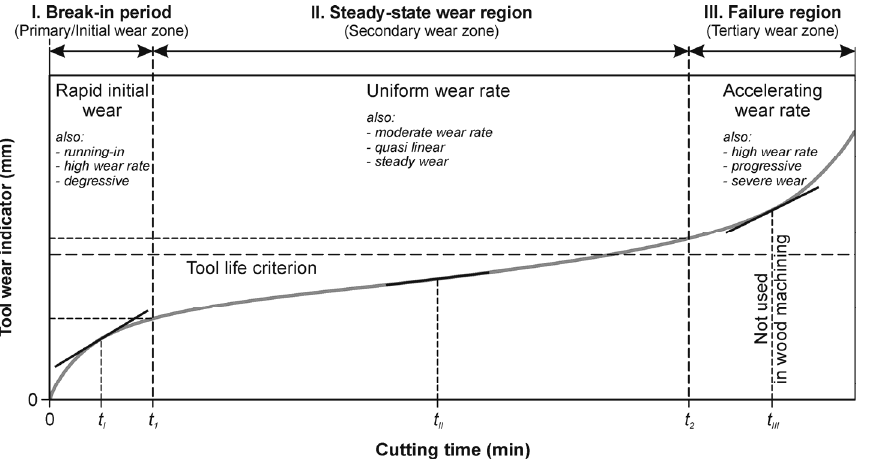
Figure 9. The classic wear curve (Lorenz) [33].